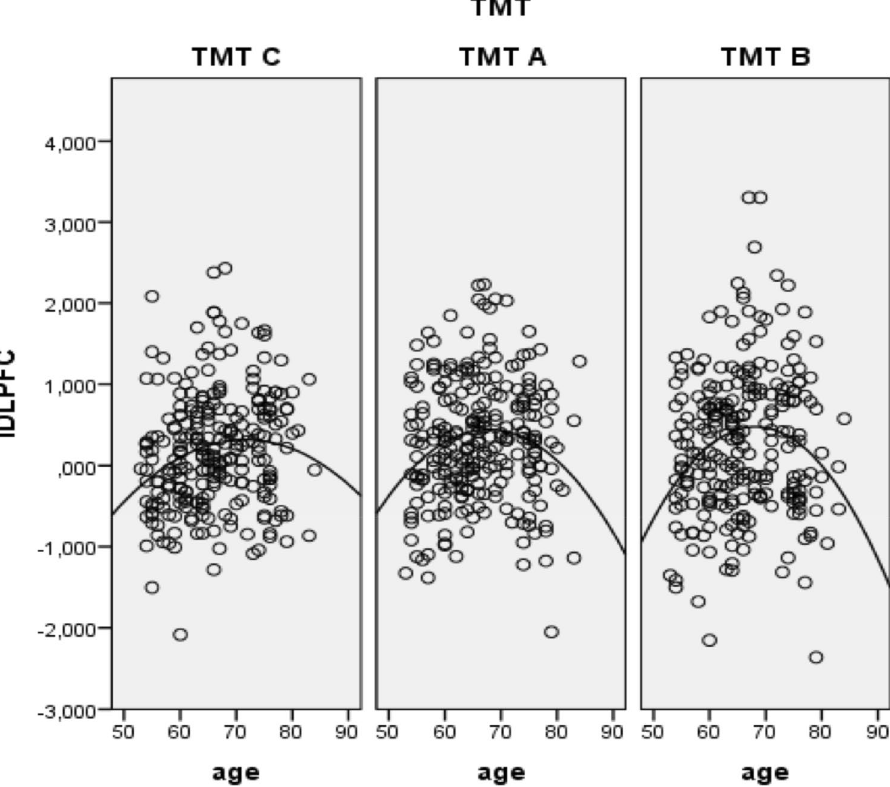
Figure 5. Negative quadratic relationship between age and fNIRS data in left